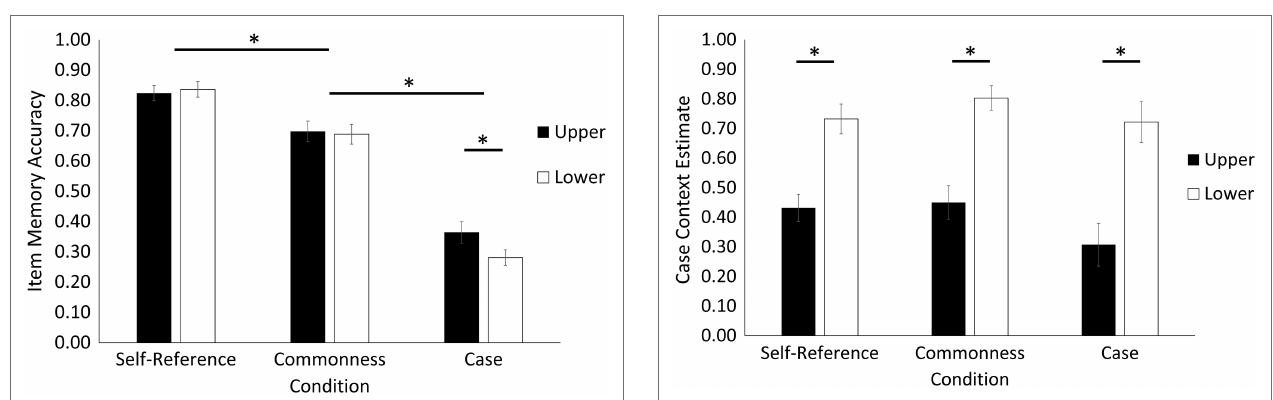
FIGURE 4 | Case context memory estimates (explicit memory) as a function of encoding condition and case. Results showed a case effect where memory was better for words presented in lower compared to upper case across all encoding conditions. Error bars represent standard error. Asterisks denote statistical difference at p < 0.05.